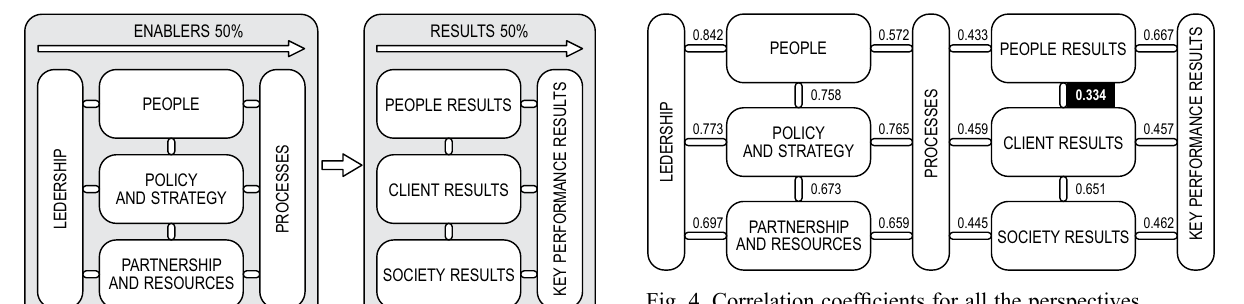
Fig. 4. Correlation coefficients for all the perspectives